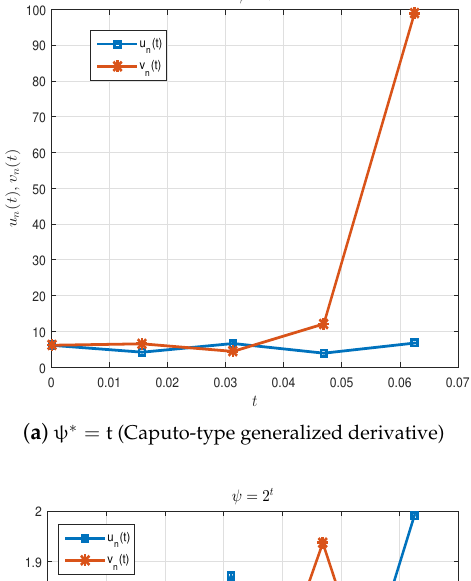
( t ) and (cid:36) ( t ) in ( a ), ( b ) and ( c ) respectively for the ψ ∗ n √ n ( t ) = t Katugampola derivative (for ρ = 0.5) and 3